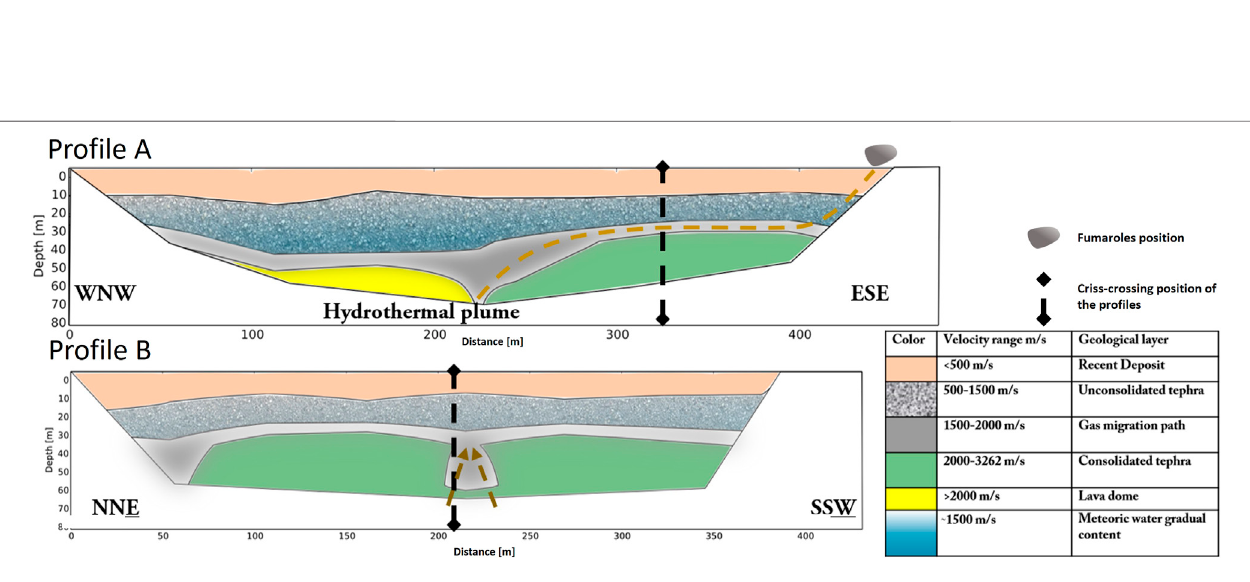
FIGURE2| Cross-sectionInterpretationofthetwoVpvelocitymodelsinGammaldietal.(2018):atthebottomWNW-ESEisthesketchrelativetomodel (A) ,tothe bottom theNNE-SSW sketchrelative tothemodel (B) . Ontheright sideisthe tableofthegeologicalinterpretation ofthevelocityrange. The distances aretoconcerning the fi rst receivers shown in Figure 1